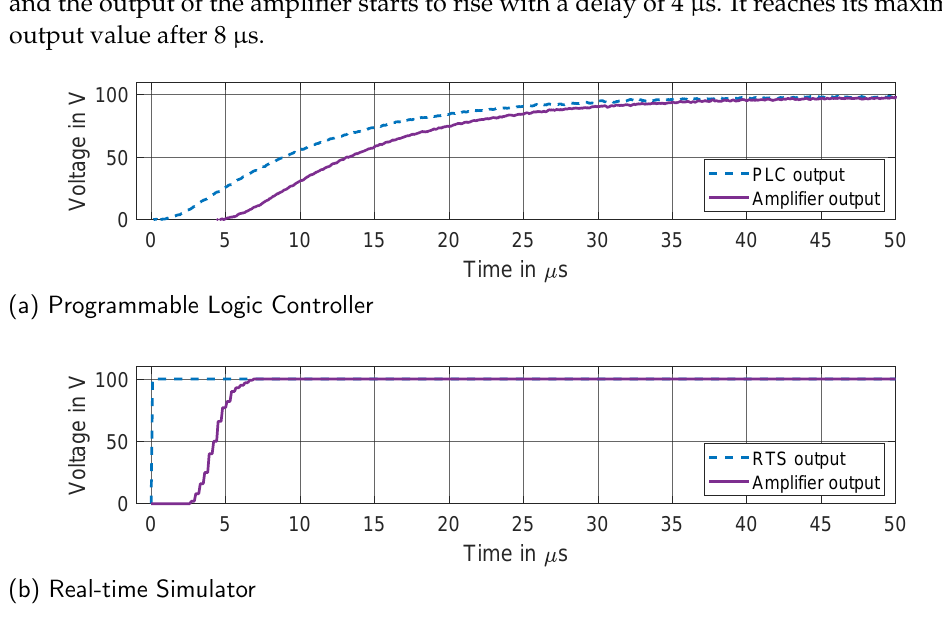
Figure 6. Simulator output, compared to the amplifier output for the Bachmann PLC ( a ) and the OPAL-RT RTS ( b ). Values of ( b ) are according